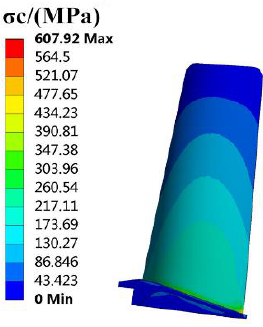
Figure 5. Distribution of blade creep stress.